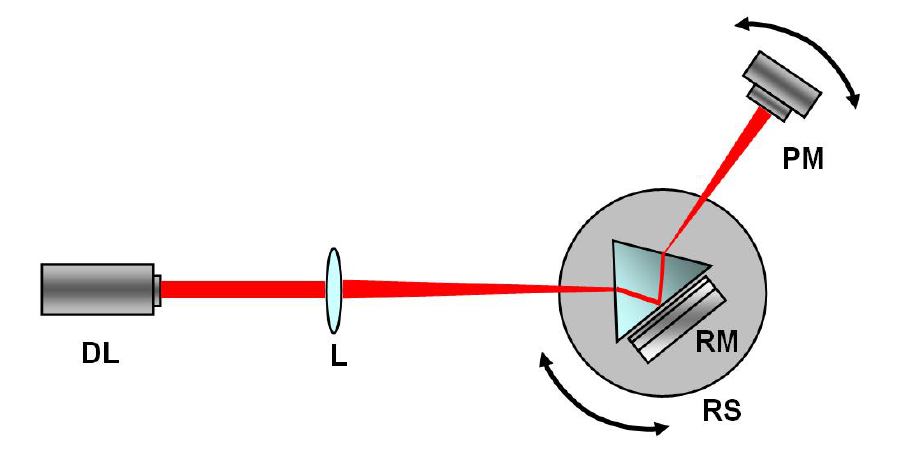
Figure 1. Experimental setup. DL: diode laser emitting s-polarized radiation at 785 nm; L: lens with focal length f=7.5 cm; RM: resonant mirror; RS: rotation stage; PM: power meter on an independent rotation